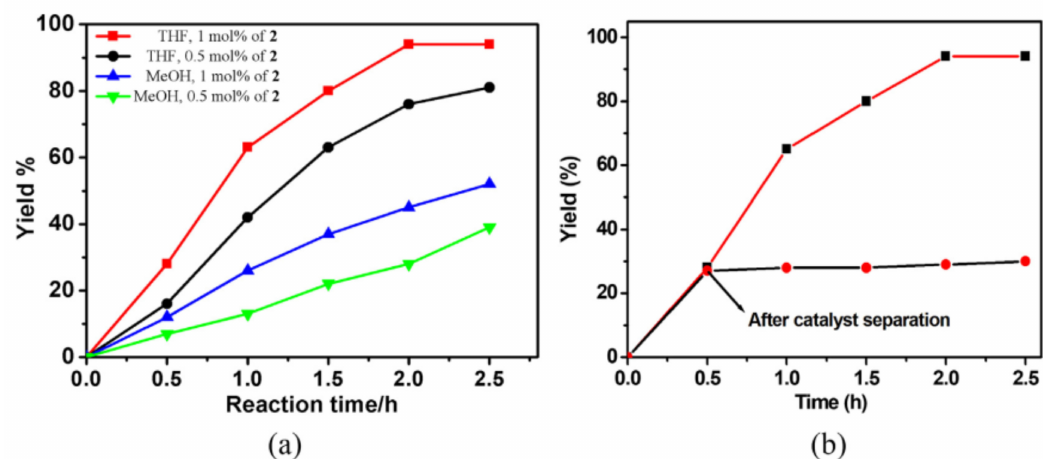
Figure 2. ( a ) Effect of type of solvent and catalyst amount on the yield of 2-benzylidenemalononitrile obtained from the Knoevenagel condensation of benzaldehyde with malononitrile using Zn–MOF (2: refer Scheme 1 for its composition) as a solid catalyst; ( b ) Hot-filtration test for the formation of 2-benzylidenemalononitrile for Knoevenagel condensation of benzaldehyde and malononitrile in the presence of Zn–MOF. Reproduced with permission from [42].